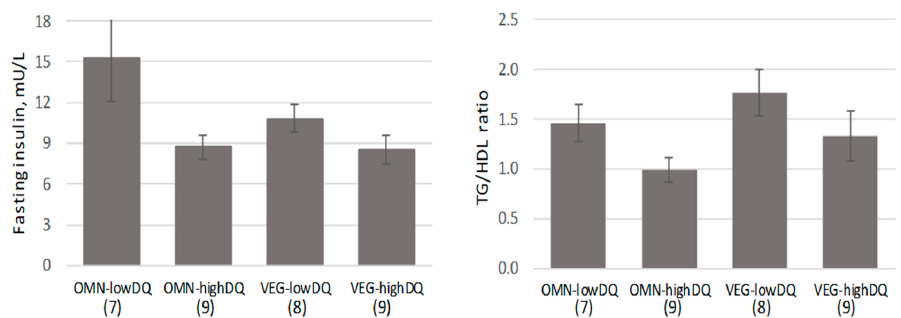
Figure 2. Fasting insulin and triglyceride (TG)/HDL ratio for diet group by diet quality (mean ± SE; n in parentheses). Biomarkers differed by diet quality grouping only; there was not a significant interaction for diet group × diet quality group (2-way analysis of variance).